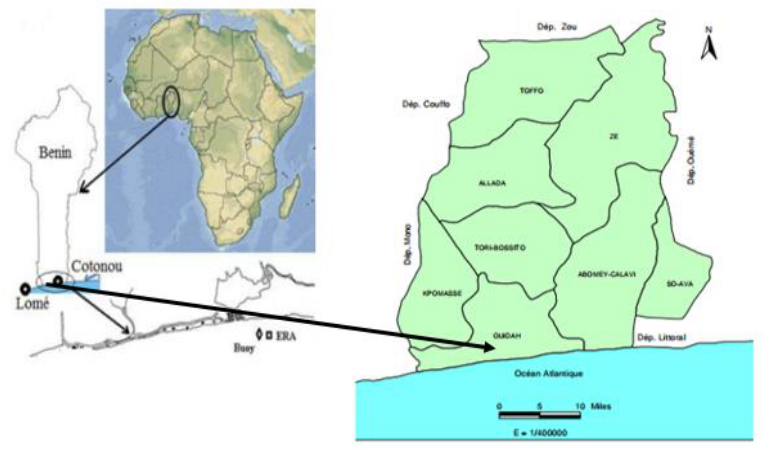
Figure 1 . Geographic location of the coastal region of Benin. Location of the commune of Ouidah [23],